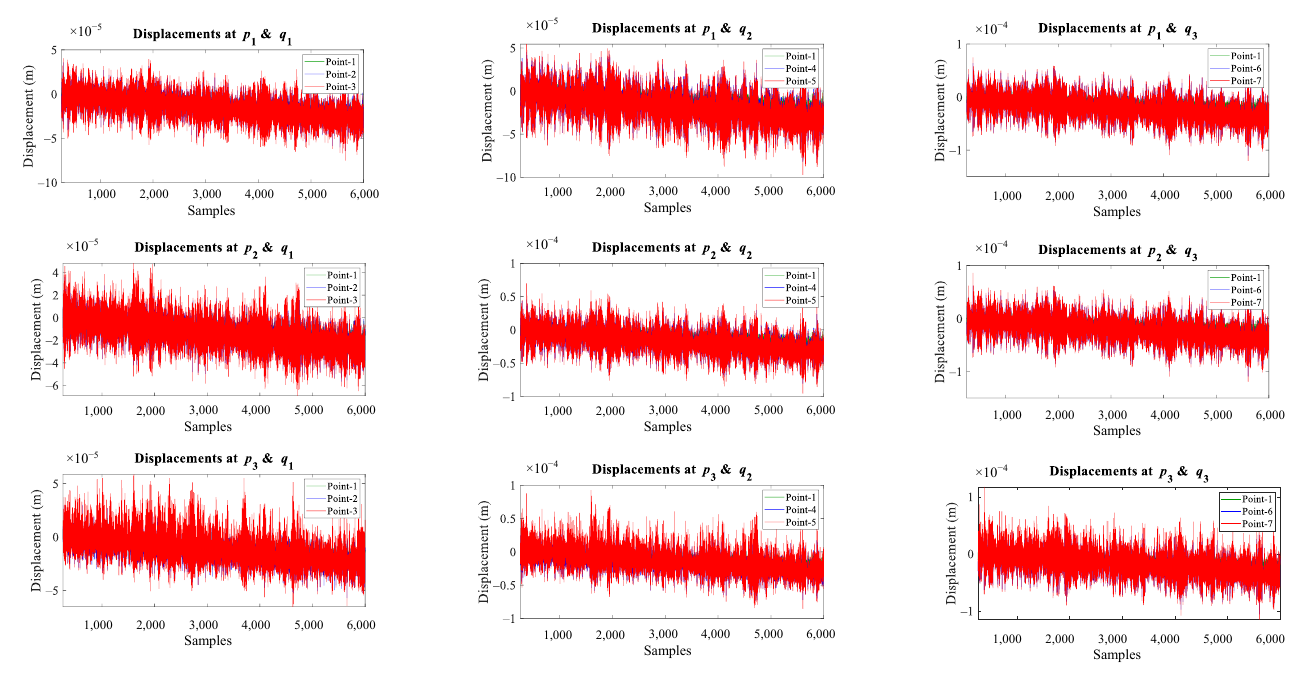
Figure 6. Sampling intervals vs. displacement responses recorded from different sensors of a cantilever beam before and after crack location.